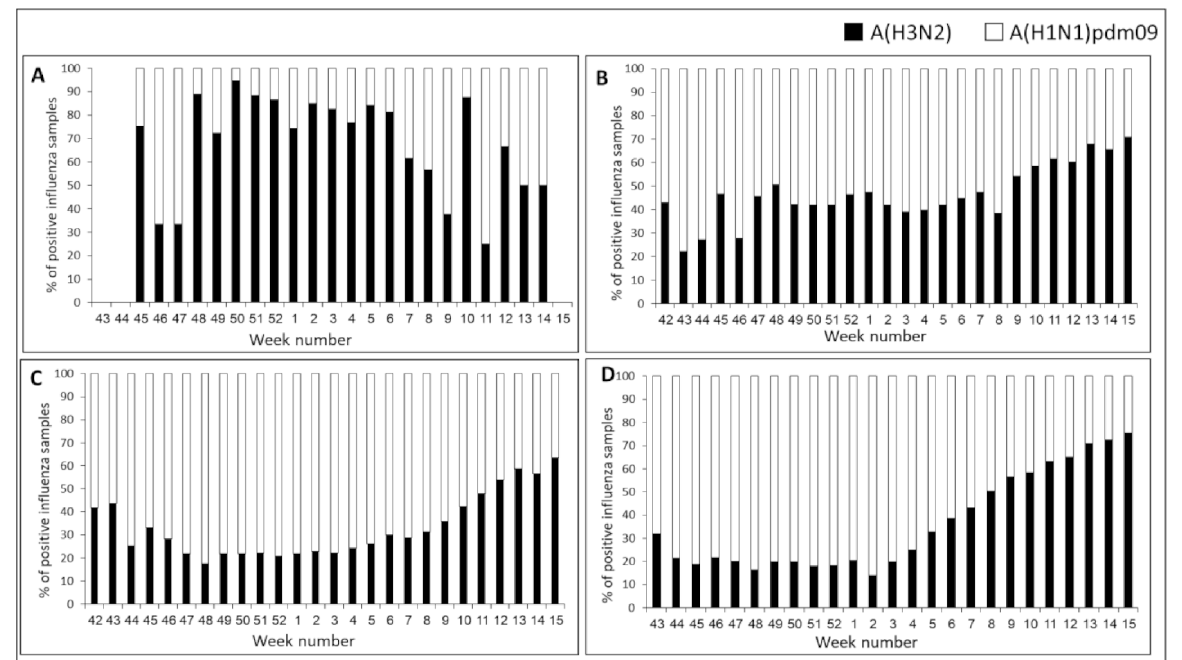
Figure 3. Influenza A subtype distribution in Israel, Europe, Asia, and USA, winter 2018–19. Weekly distributions (%) of influenza A(H3N2) (black bars) and A(H1N1) pdm09 (white bars) in Israel ( A ), Europe ( B ), Asia ( C ), and USA ( D ) for the 2018–2019